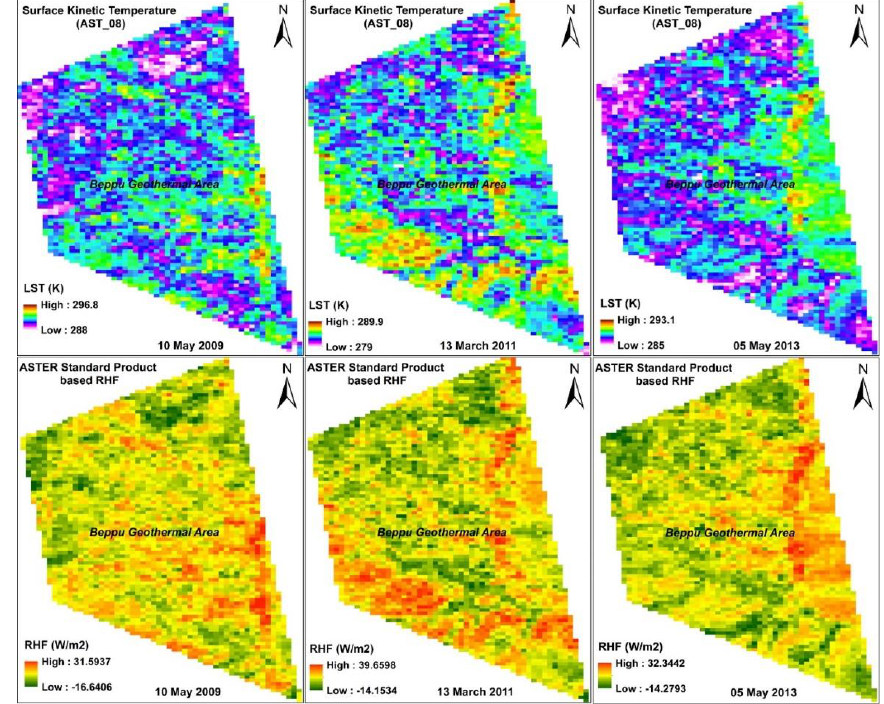
Figure 19. High level ASTER product of surface kinetic temperature (AST_08) of the Beppu geothermal area from 2009 to 2013 are shown in the top row . RHFs are retrieved from the ASTER standard products of emissivity (AST_05) and surface kinetic temperature (AST_08) from 2009 to 2013 of the Beppu geothermal area, shown in the bottom row .